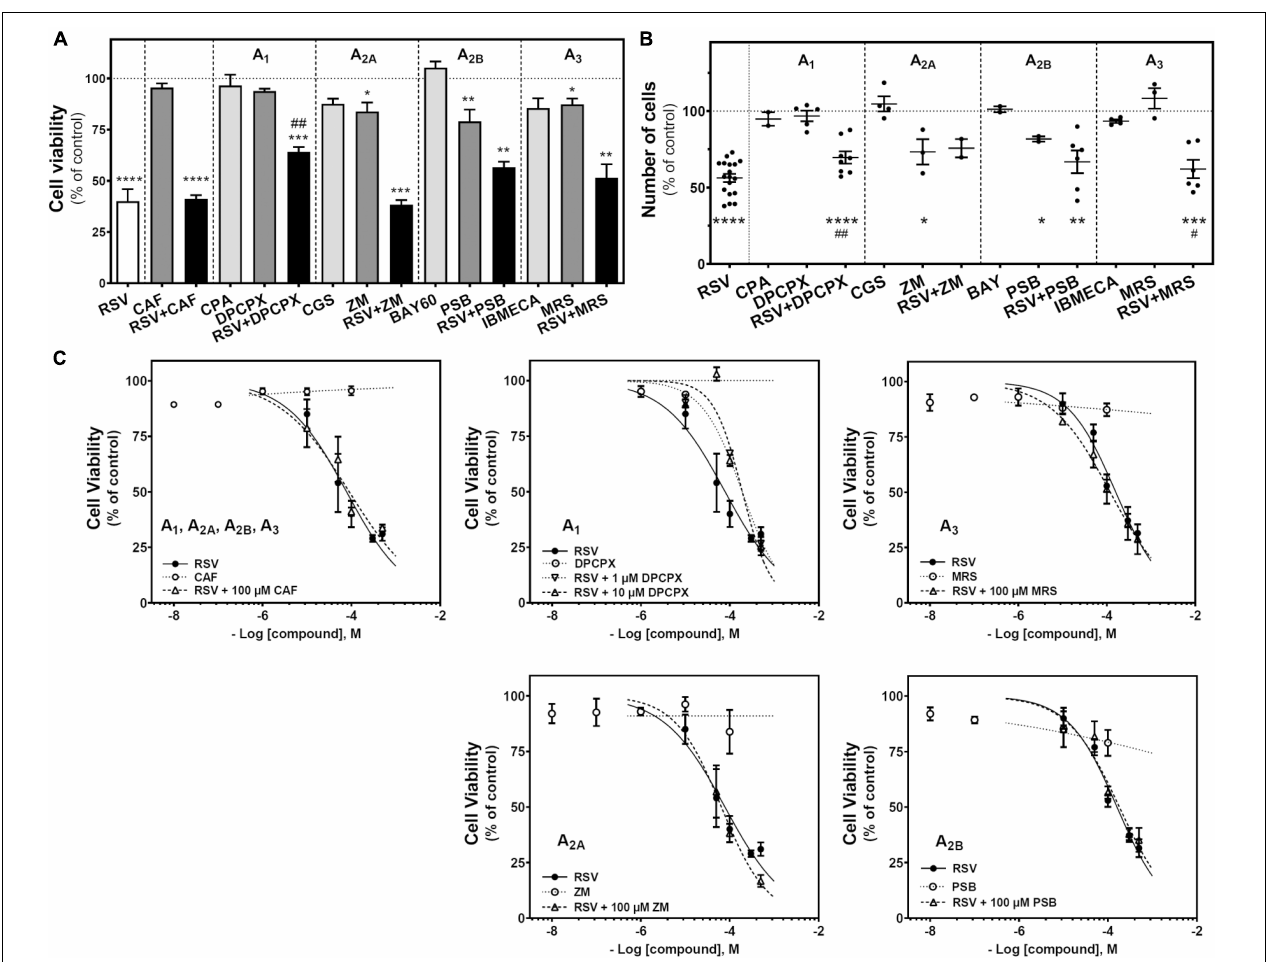
FIGURE 2 | Effect of RSV and adenosinergic ligands on C6 glioma cell growth. (A) Cell viability after 24 h of treatment with 100 µ M RSV, 100 µ M CAF, 10 µ M CPA, 10 µ M DPCPX, 10 µ M CGS, 100 µ M ZM, 10 µ M BAY60, 100 µ M PSB, 10 µ M IBMECA, and 10 µ M MRS alone or in combination. (B) Number of cells